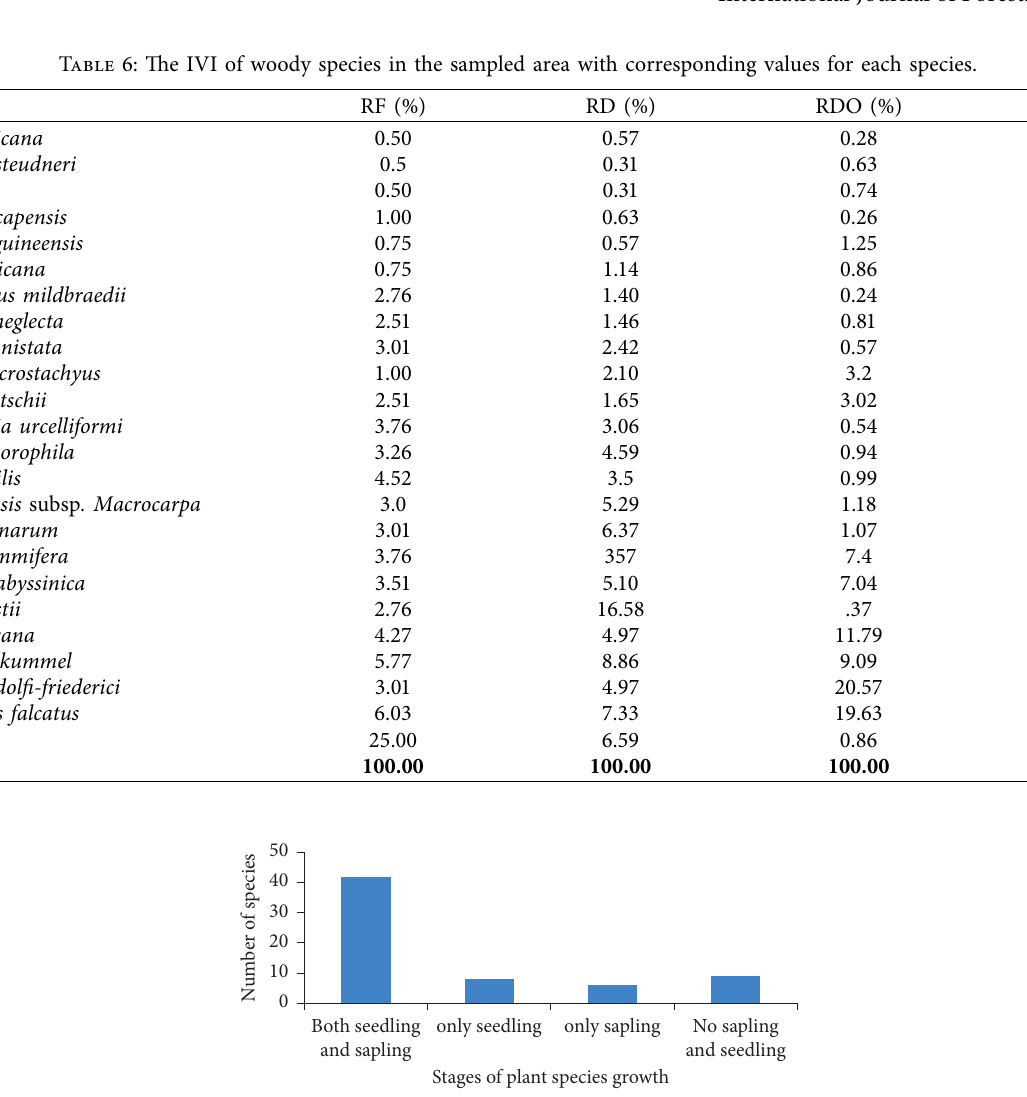
Figure 6: The number of plant species with seedling, sapling, and matured